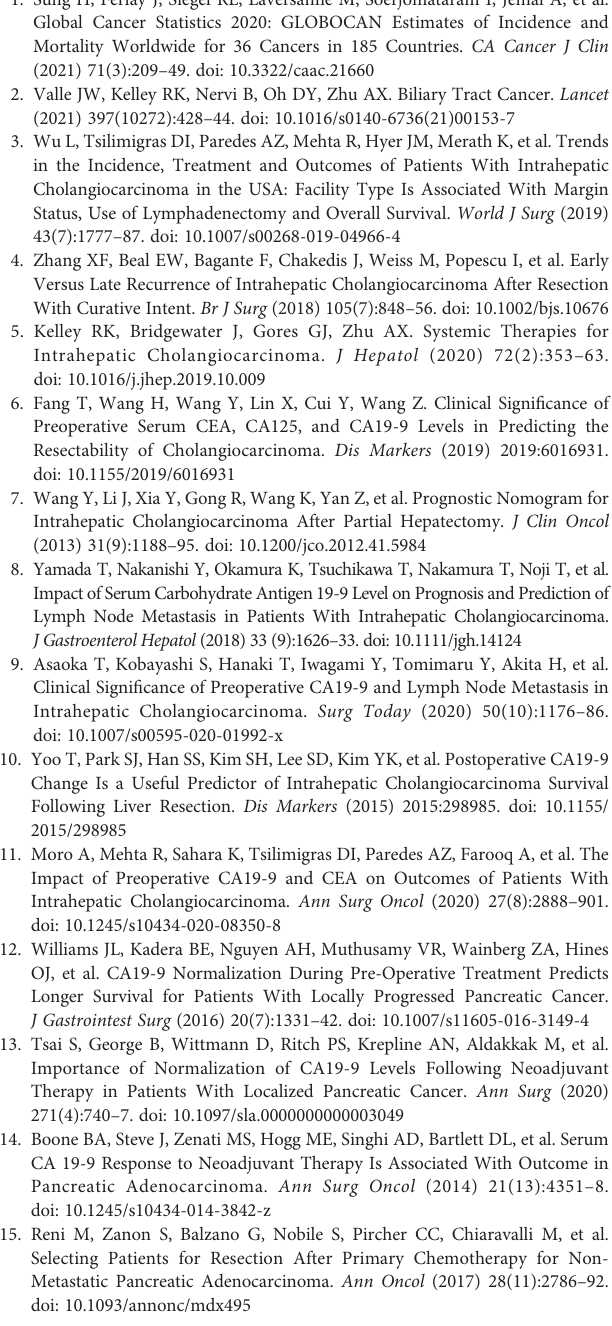
Supplementary Figure S4 | Long-term survival by preoperative and postoperative CA19-9 levels using lowest value during follow-up. (A) , recurrence- free survival of patients with normal preoperative versus normalized or persistently elevated postoperative CA19-9. (B) , overall survival of patients with normal preoperative versus normalized or persistently elevated postoperative